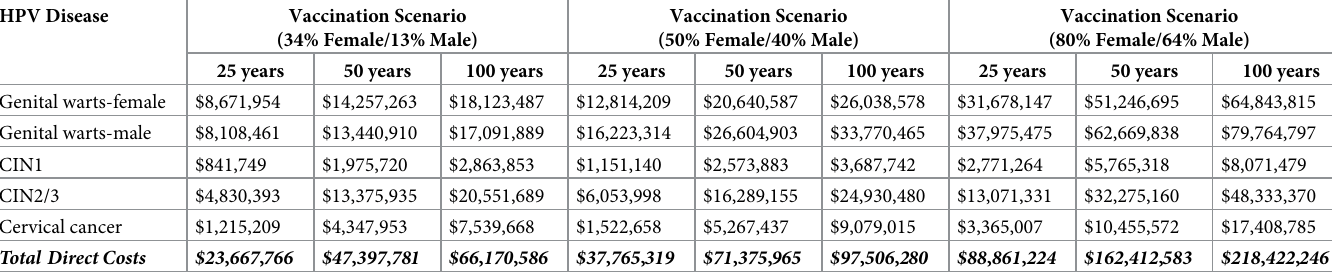
Table 1. Estimated cumulative incidence costs avoided since HPV4 vaccination program started, by vaccination scenario. HPV